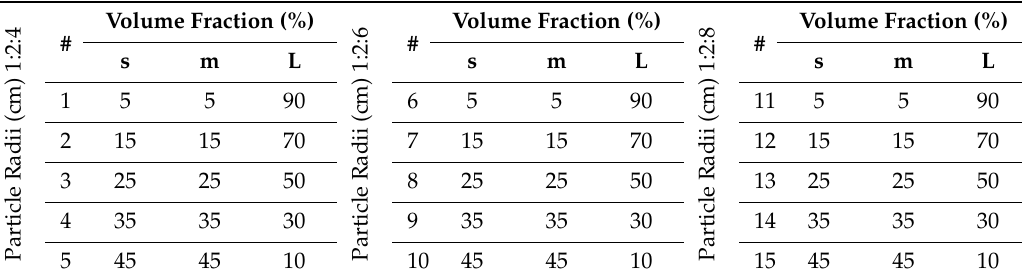
Table 2. Ternary mixture composition and particle size